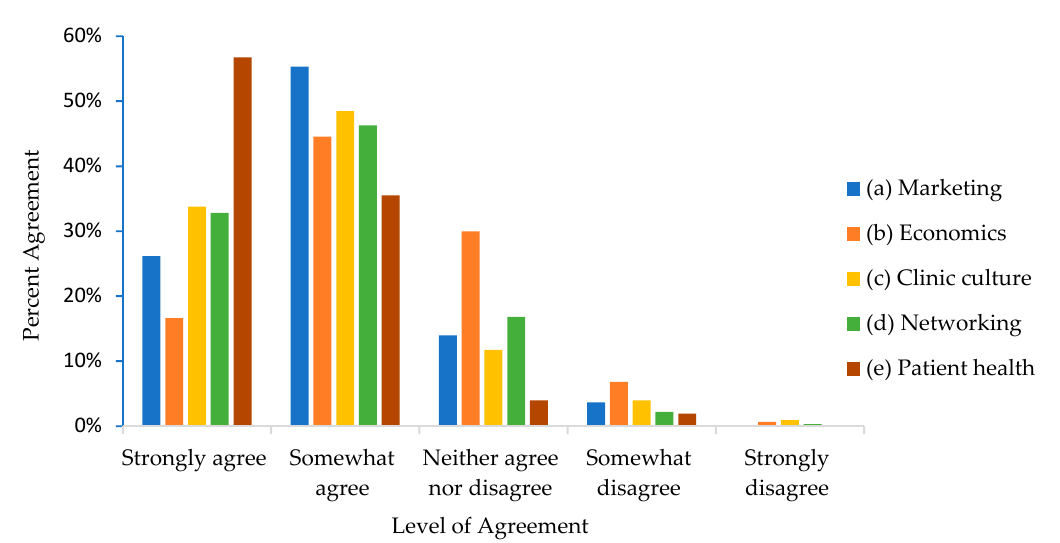
Percent Agreeing 77.3% 69.1%